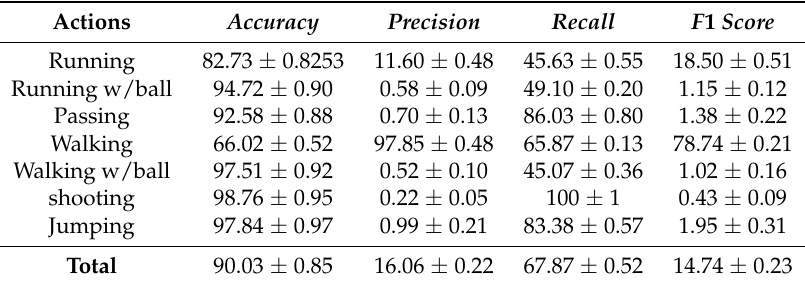
Table 6. ANN Evaluation Metrics.